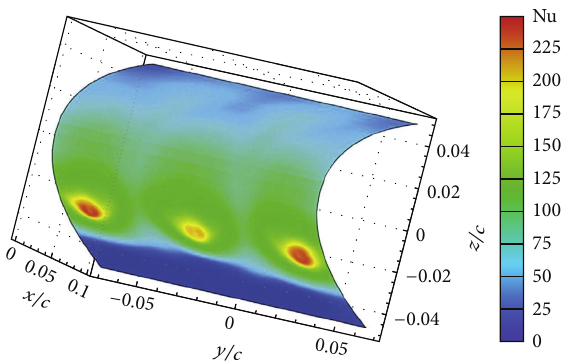
Figure 17: Nusselt number reconstruction for 𝑑 = 4 mm, 𝜙 = 30 ∘ , 𝑀 = 1.0 , and 𝑝/𝑑 = 15 ; adapted from Imbriale et al.